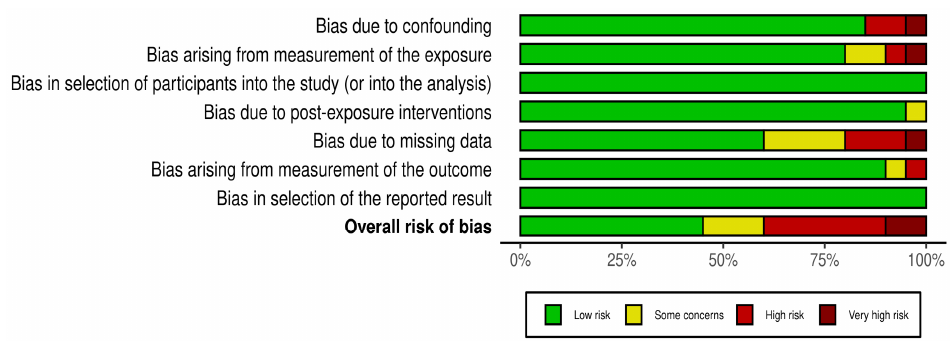
Figure 3. Assessment of the risk of bias of each ROBINS-E domain taking together all studies included in this review.